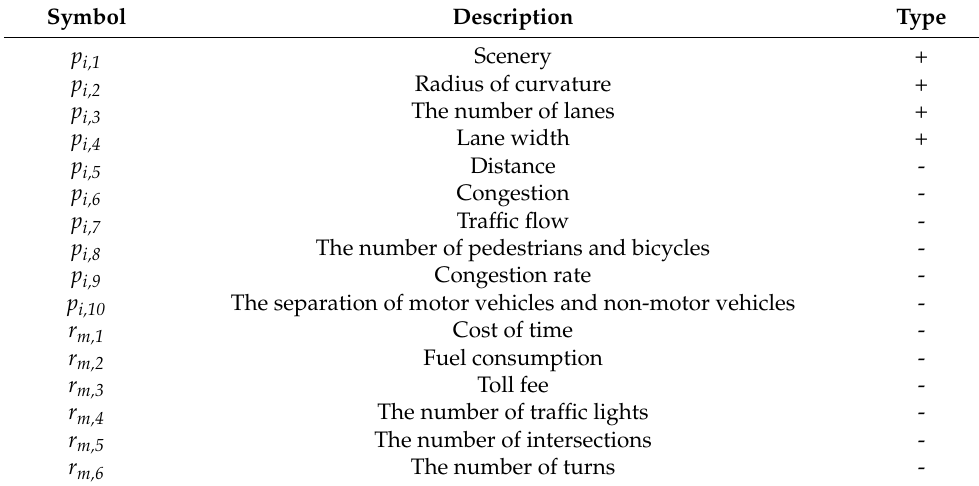
Table 2. Definitions of attributes. Symbol Description Type Scenery + Radius of curvature The number of lanes